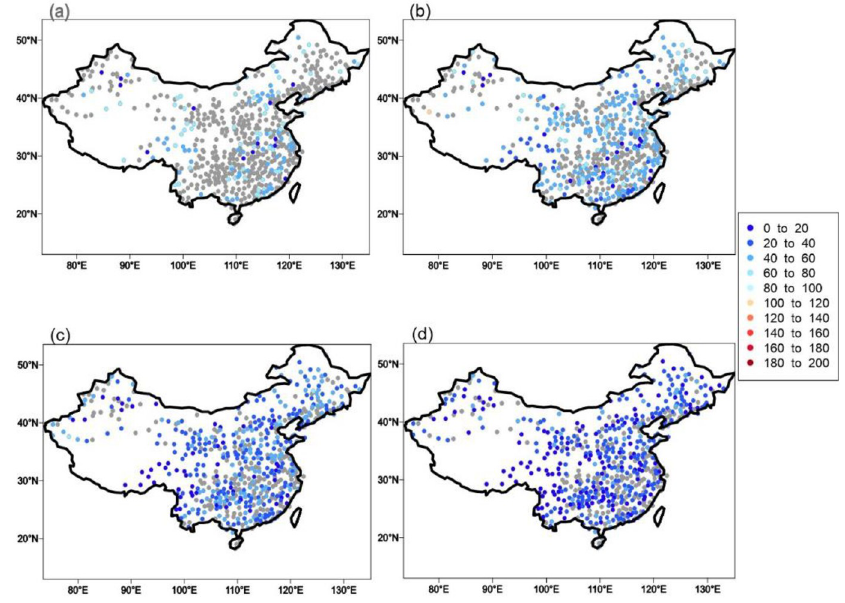
Fig 6. Same as Fig 5, but for 100-year extreme precipitation events. (Made with Natural Earth. Free vector and raster map data @ naturalearthdata.com).